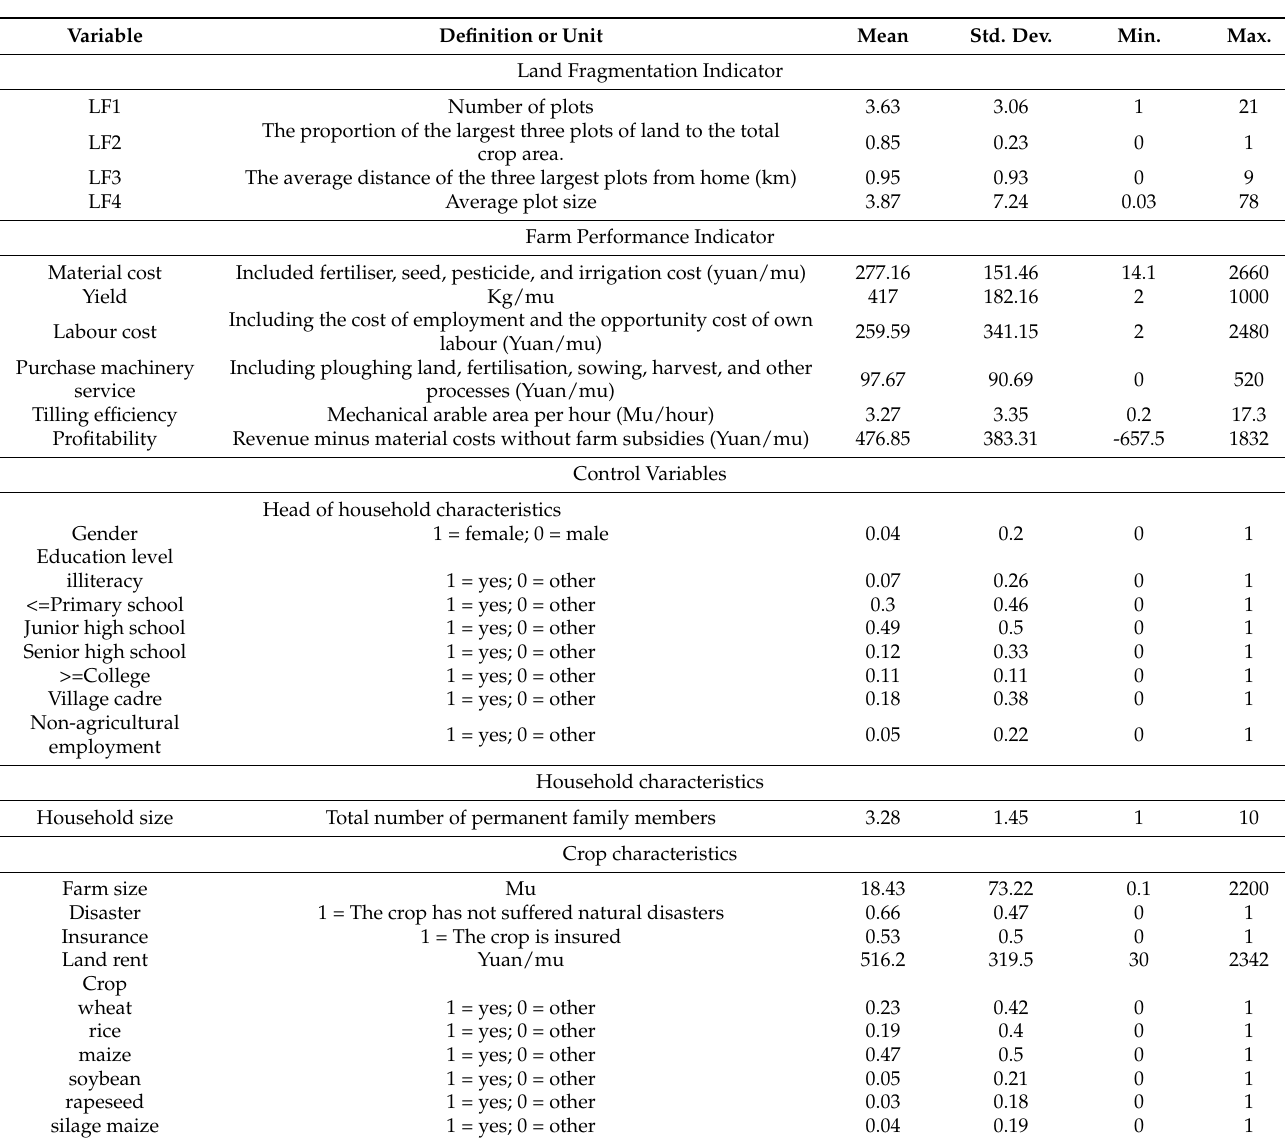
Table 2. Descriptive statistics and variable